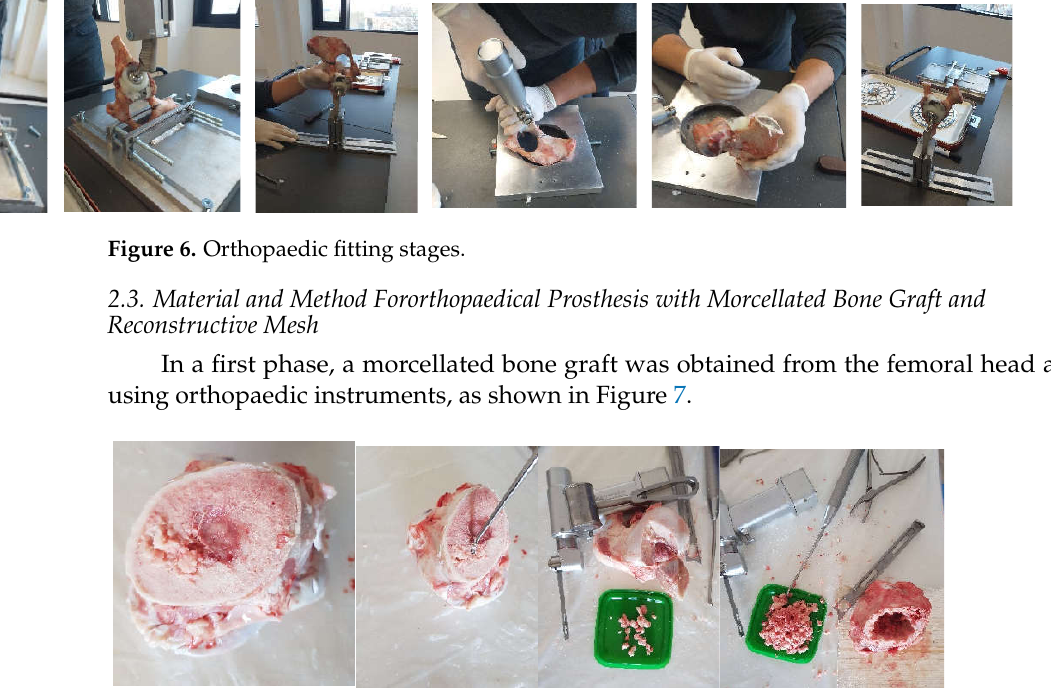
Figure 5. Steps for fixation of prosthesis elements using orthopaedic cement. This prosthesis is to be placed on a universal test machine. After the prosthesis is